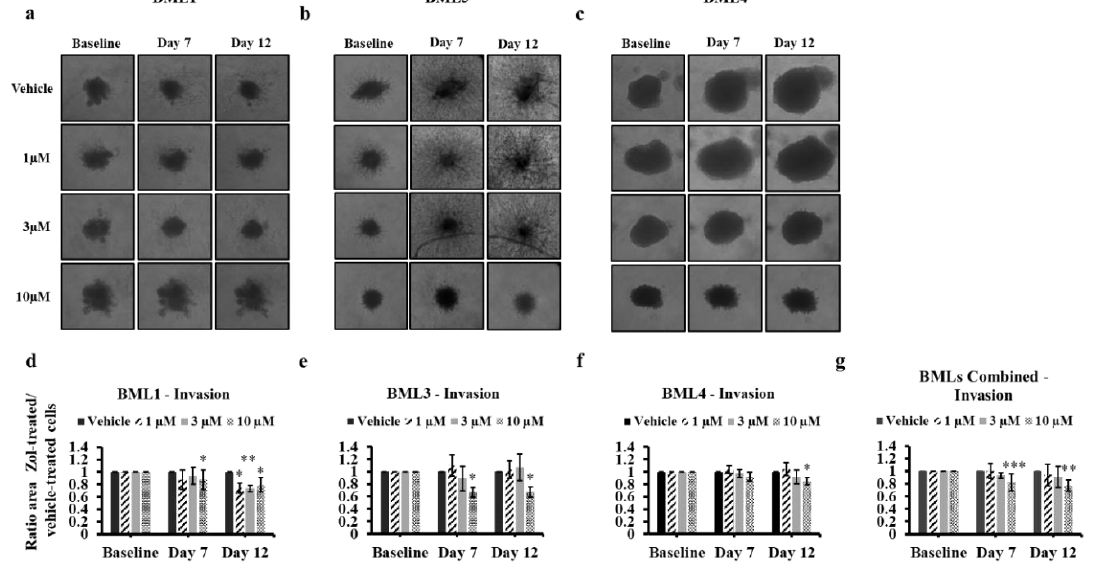
Figure 7. Spheroid invasion assay of lung cancer-induced bone metastasis cells treated with vehicle (PBS1x) or Zol 1 µM, 3 µM and 10 µM for 7 and 12 days in 1% serum conditions. Representative brightfield images of bone metastasis cell spheroid growth ( a – c ) within the invasion matrix from vehicle or Zol-treated conditions. Histograms for growth in the matrix ( d – g ) showing the ratio of drug-treated cells divided by vehicle-treated cells (PBS1x) ± SD for three independent experiments. ( g ) combined ratio for the three cell types of bone metastasis cells are presented. Each condition (drug-treated cells or vehicle-treated cells) on each day was normalized to day 0 and then to vehicle. Significantly different from control * p < 0.05, ** p < 0.01 and *** p < 0.001.